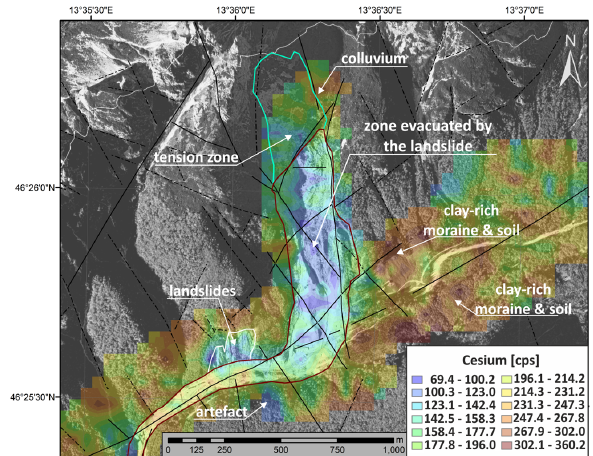
Fig. 9. Gamma ray survey: a map of Cesium combined with the fault and joint pattern (black full and dot-and-dashed lines), and the geological interpretation; the units are counts per second [cps] (Source of data: Geological Survey of Austria and Google